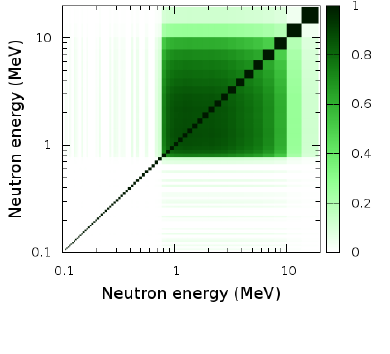
Figure 3. (color online) Correlation matrix of the measured 681 keV (n,n’ γ ) cross